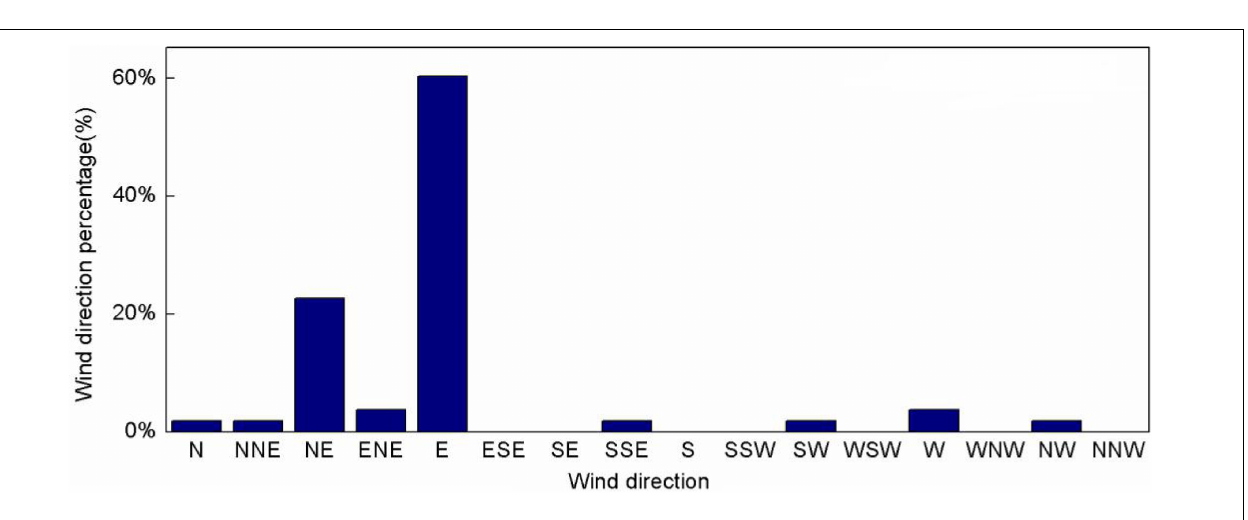
FIGURE 10 | Frequencies of the average wind direction at Taishan